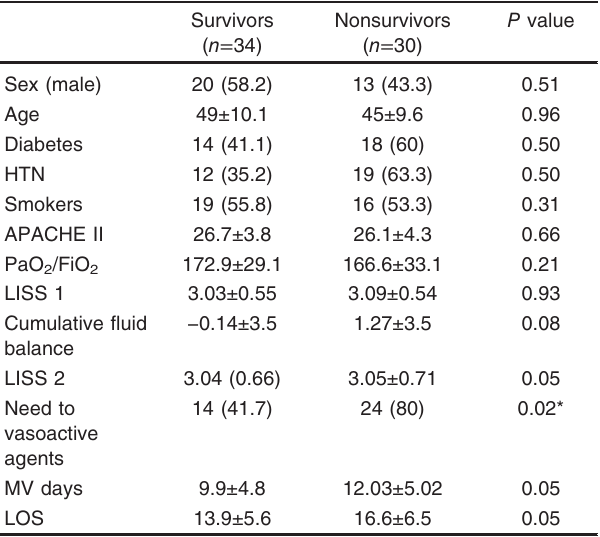
Table 3 Comparison between survivors and nonsurvivors in their general characteristics